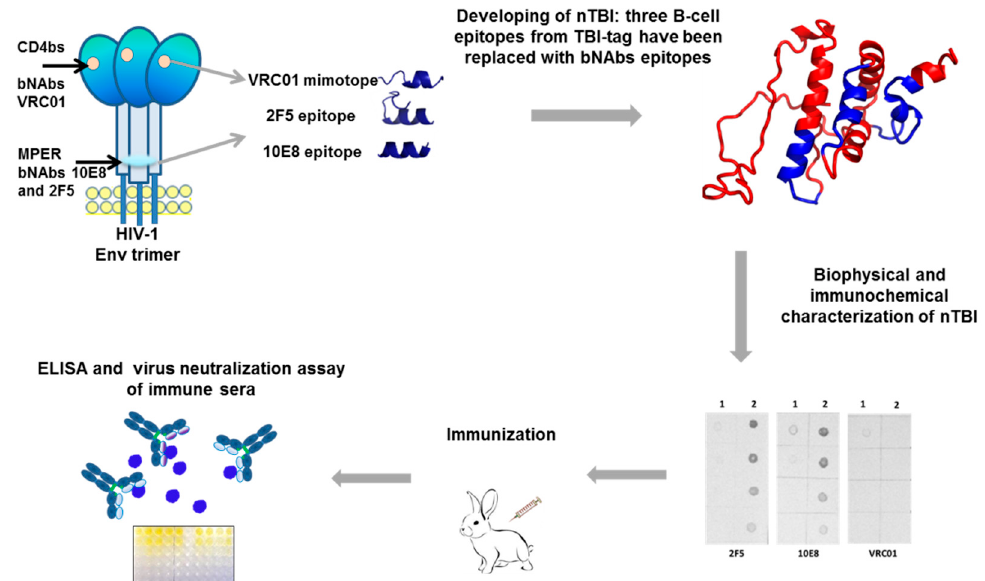
Figure 1. Schematic presentation of the experimental strategy for development of the nTBI protein and studying its immunogenic properties. A spatial model of the nTBI protein structure was obtained using the I-TASSER (Iterative Threading ASSEmbly Refinement) method [45].